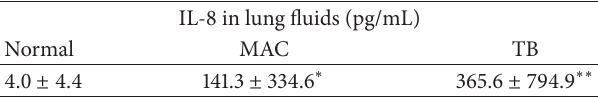
Table 3: Concentration of IL-8 (pg/mL) in lung fluids from: normal subjects (10 subjects), patients infected with MAC (10 patients), and patients infected with TB (15